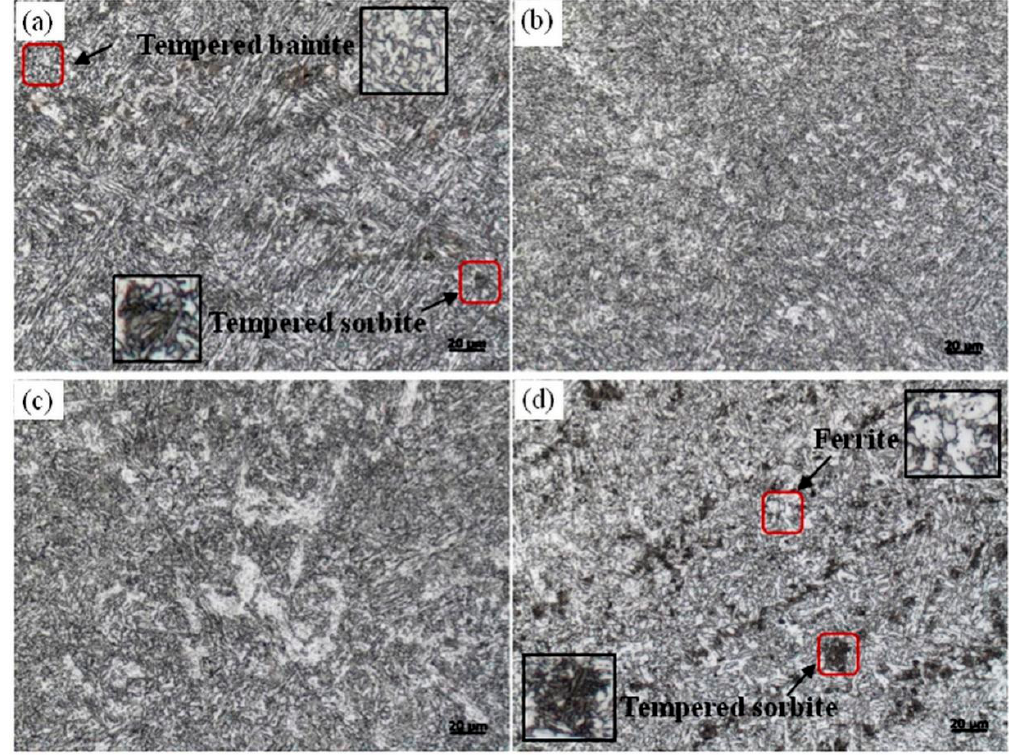
Figure 8. Phase transformation of different parts of the component: ( a ) bottom part; ( b ) part close to the bottom part; ( c ) middle part; ( d ) top part.